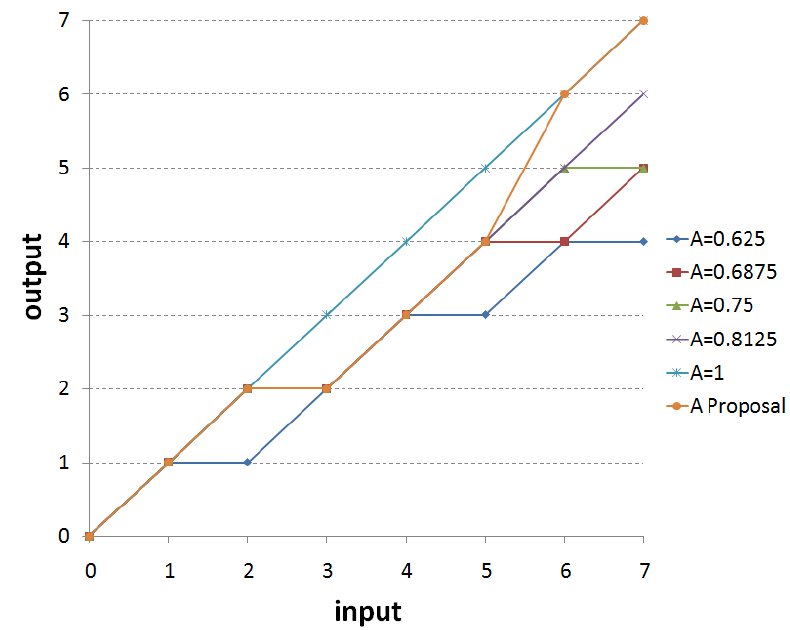
Figure 10. Different normalization functions investigated for a 4-bit precision (3-bit module)